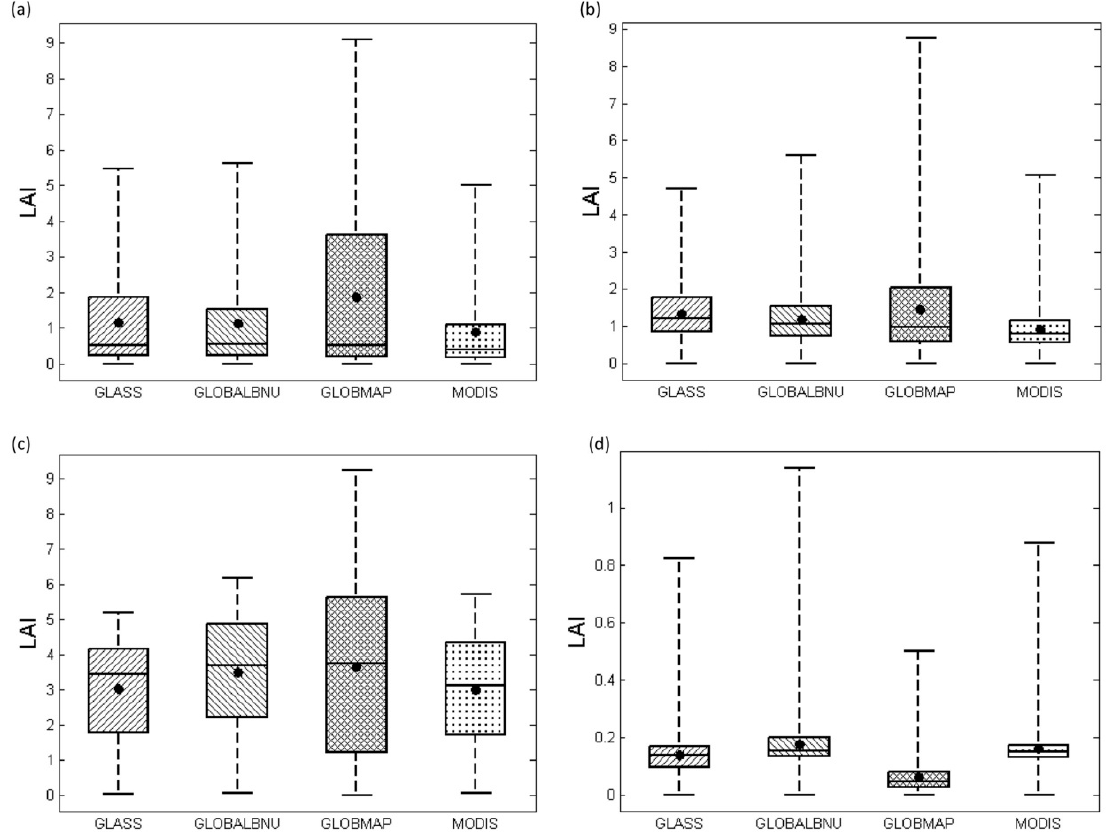
Figure 15. LAI boxplots of typical regions: ( a ) region A; ( b ) region B; ( c ) region C; ( d ) region D.